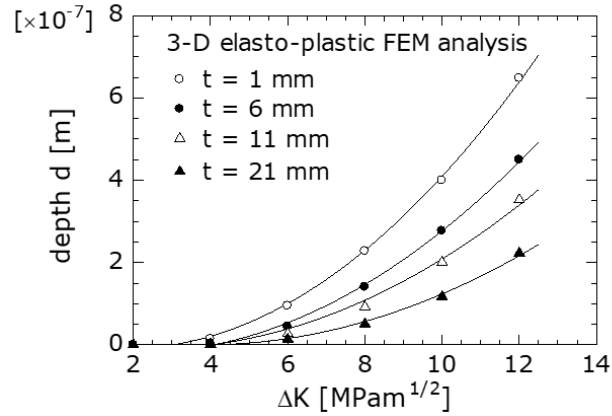
Figure 11. Relationship between depth d and ΔK